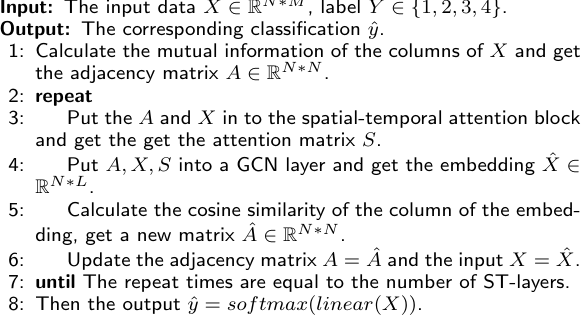
Algorithm 1 The process of motor imagery classification